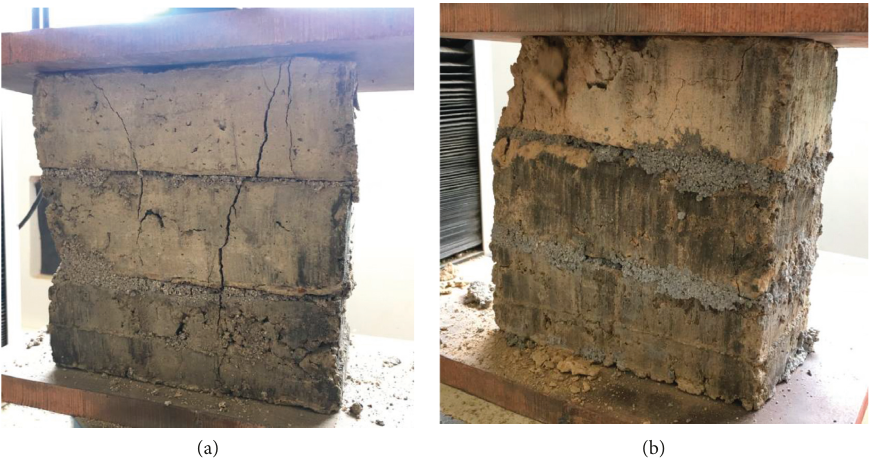
Figure 2: Failure pattern of masonry prisms.